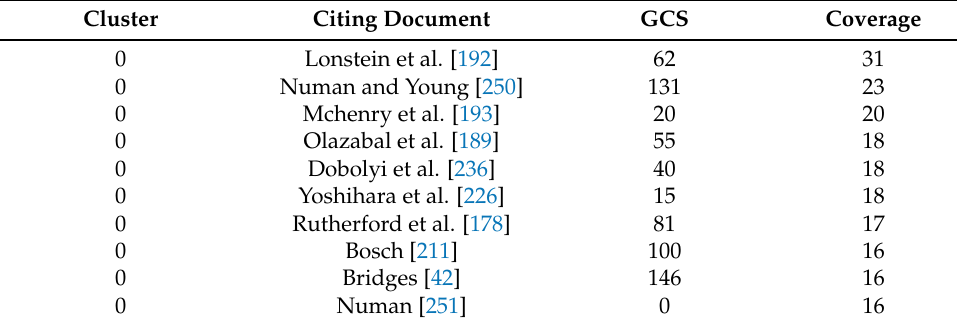
Table 7. Major 10 citing documents in cluster #0 identified using the